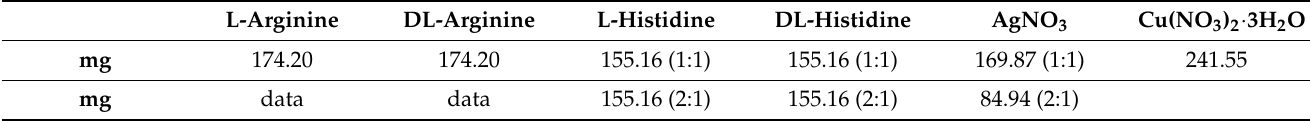
Table 3. Mass quantities of the materials used in the solution-based synthesis (expressed in mg). L-Arginine DL-Arginine